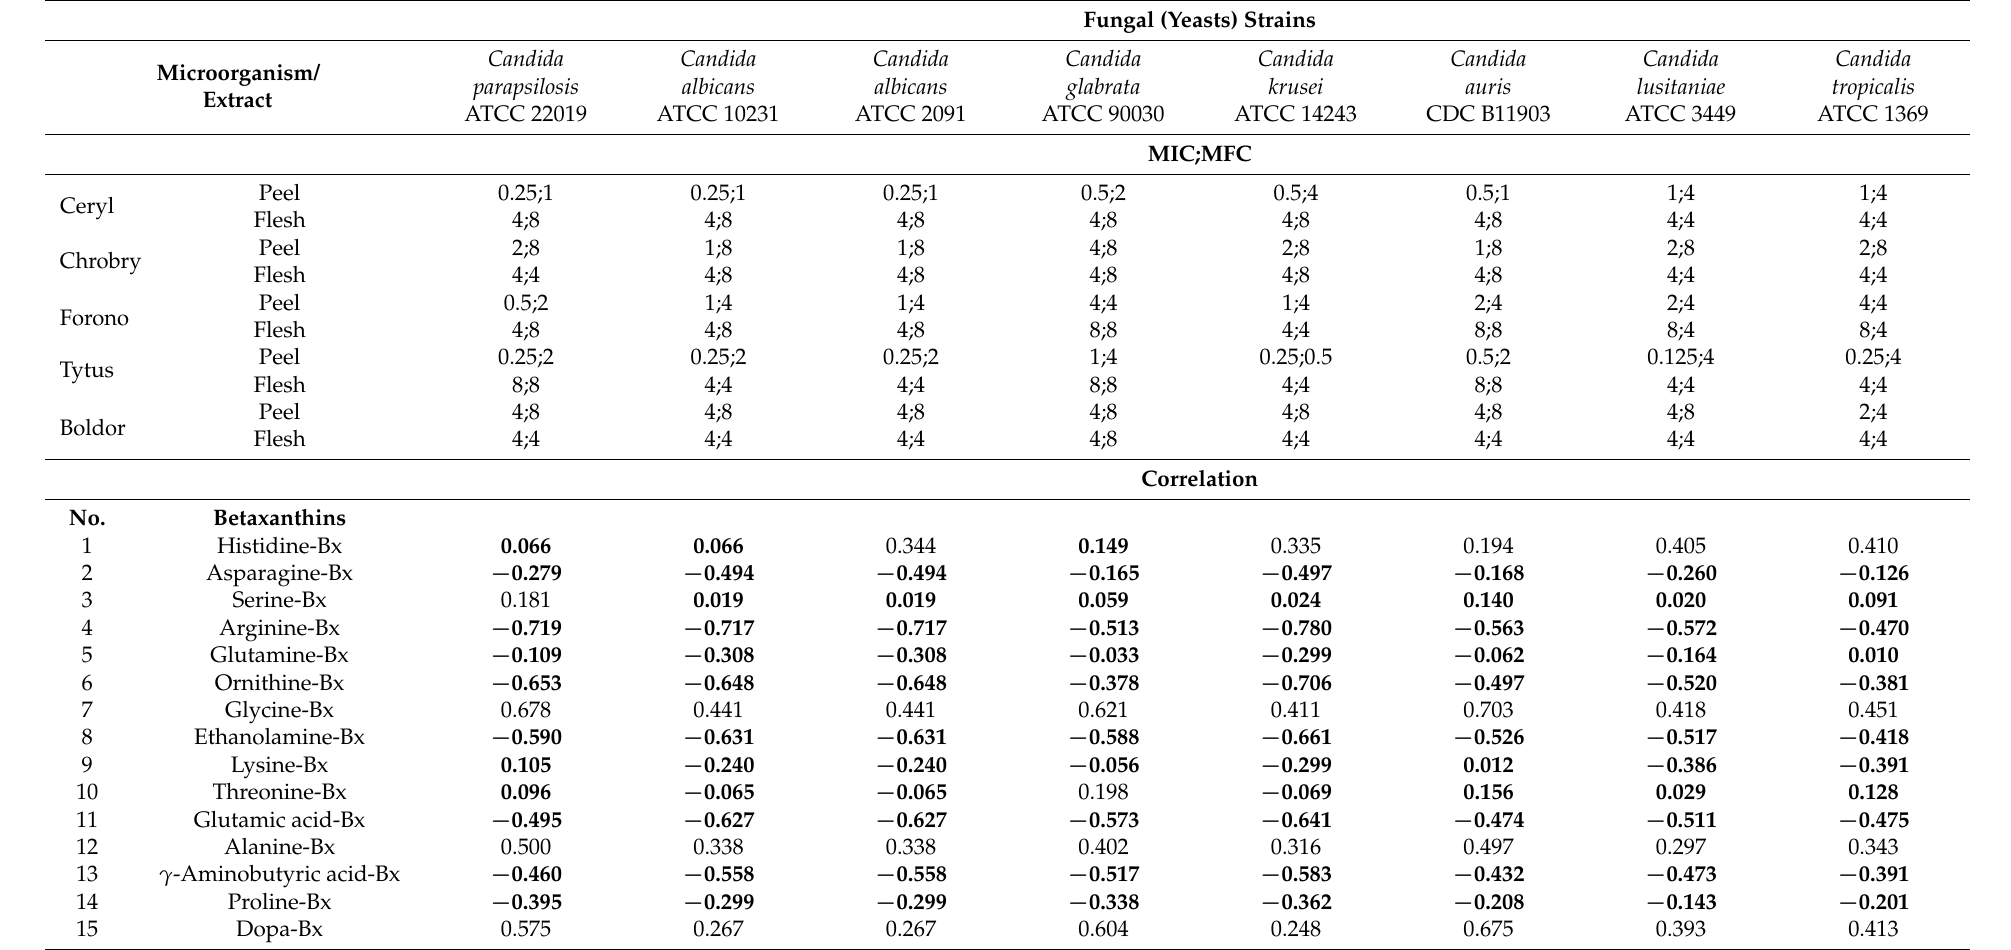
Table 6. Antimicrobial activity of extracts obtained from red and yellow B. vulgaris cultivars assessed as MIC (minimum inhibitory concentration) and MFC (minimum fungicidal concentration) against Candida species and correlation coefficients between identified betaxanthins (absolute peak areas) and microbial activity (MIC values). Statistical significance is marked by font: boldface means 95% significance, and normal font lack of significance at